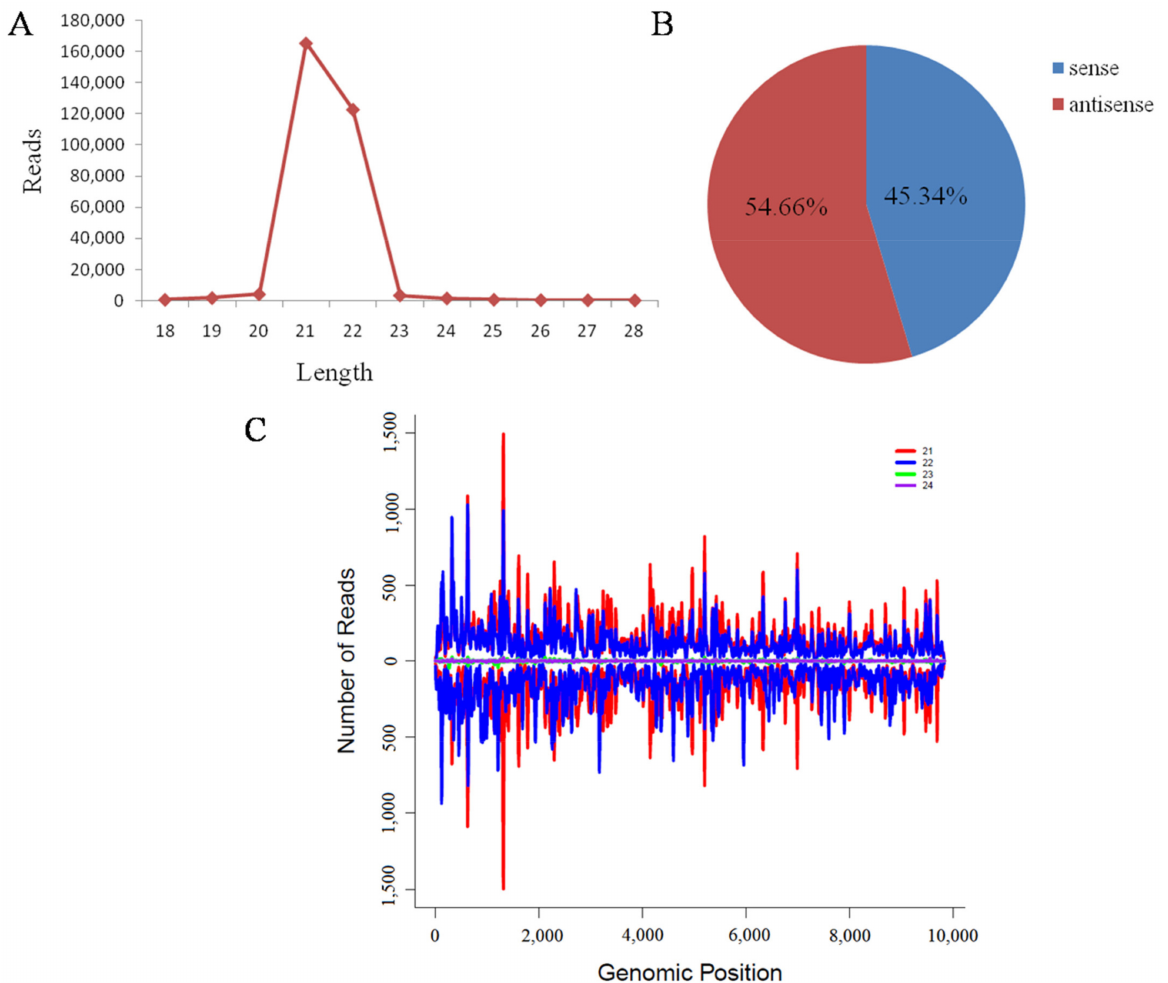
Figure 4. Profile of small RNAs derived from marigold mosaic virus (MMV). ( A ): Size distribution of 18–28 nt siRNAs derived from MMV. ( B ): the polarity distribution of MMV derived siRNAs. ( C ): The single-nucleotide resolution map of vsiRNAs along MMV genome, in either sense (bars above the axis) or antisense (bars below the axis)